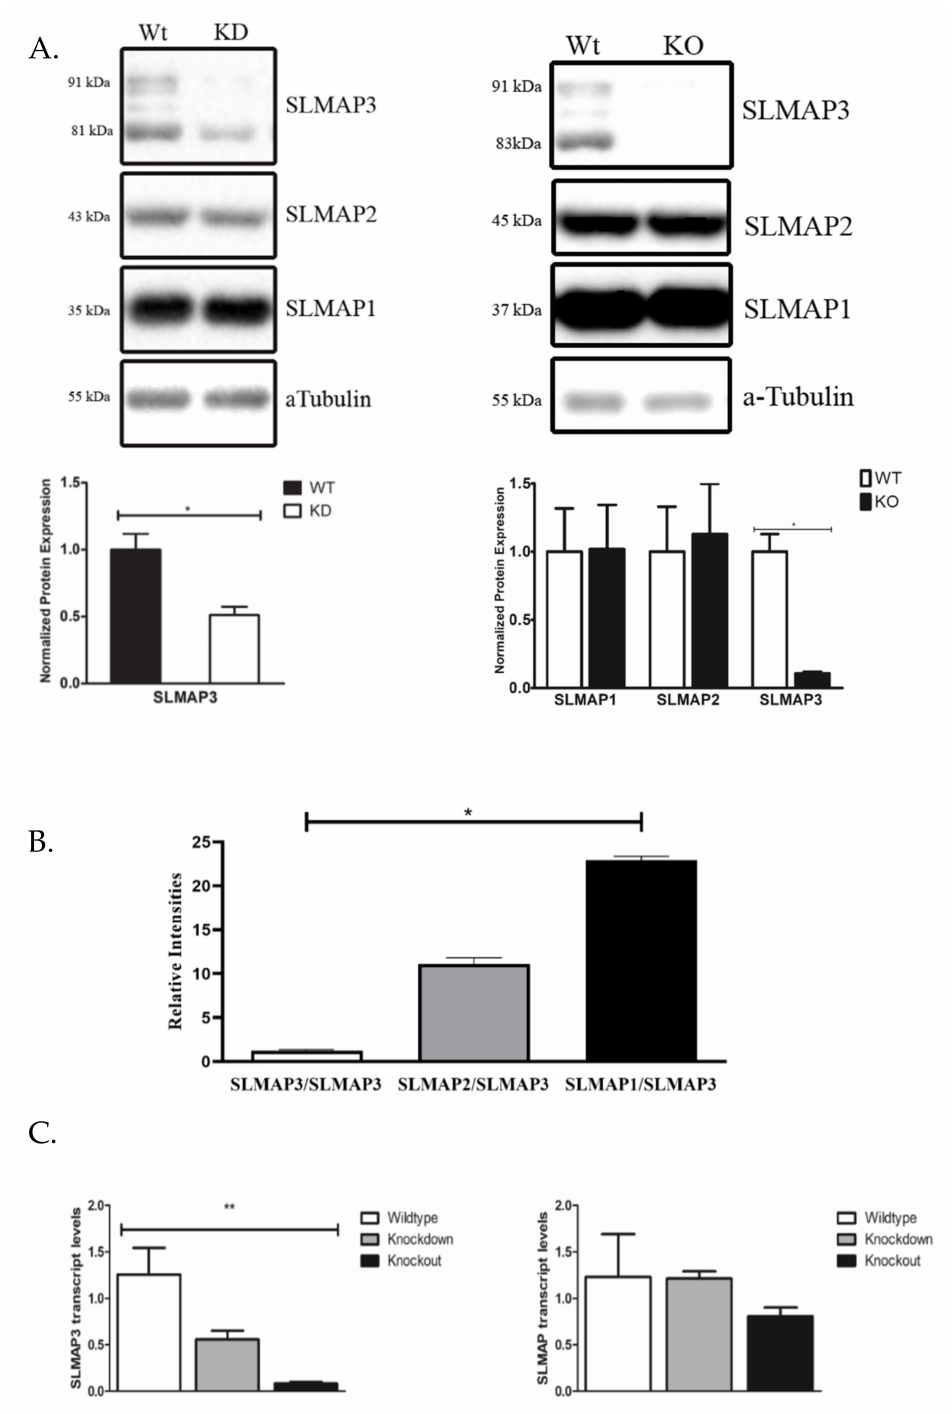
Figure 5. Protein and transcript expression of SLMAP isoforms in targeted mice. ( A ) Western blot with anti-SLMAP for protein expression in Wt, KD and KO hearts. Bar graphs represent normal- ized protein expression evaluated via densitometry analysis by using α -Tubulin as a loading control. n = 10. * ρ < 0.05, ρ value was calculated using a non-paired two-way t -test. ( B ) Relative intensity of protein band ratios of SLMAP2 and SLMAP1 normalized to SLMAP3 from western blots in Wt hearts. n = 3 * ρ < 0.05. ( C ) Transcript levels for SLMAP3 and total SLMAP in KD and KO hearts compared to Wt. Fold change was calculated using 18S-Ribosome as control. n = 9. ** ρ < 0.001, ρ value was calculated using ANOVA statistical